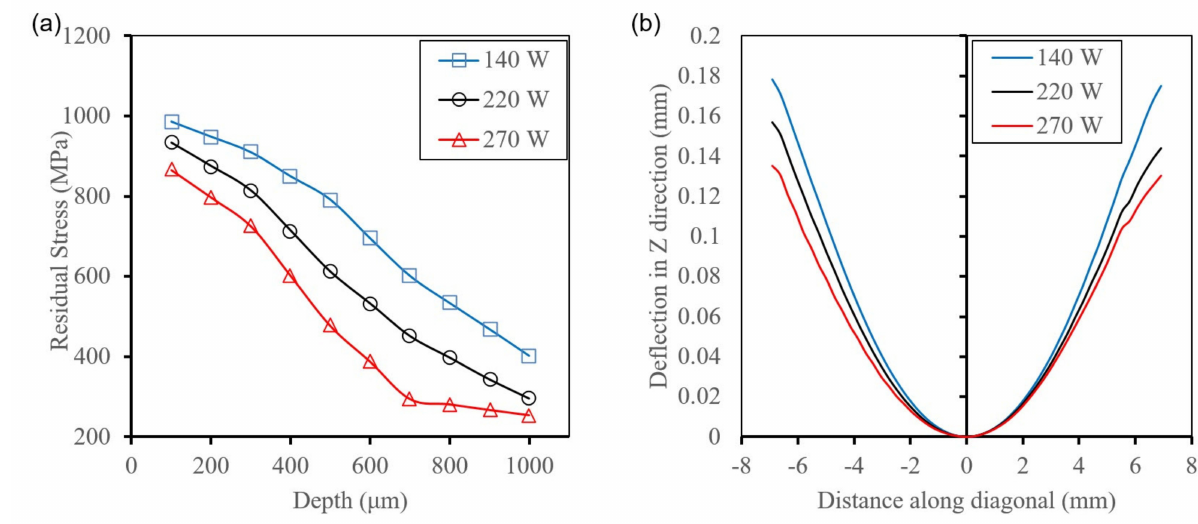
Figure 46. Effect of laser power on ( a ) in-depth RS and ( b ) deflection in the Z